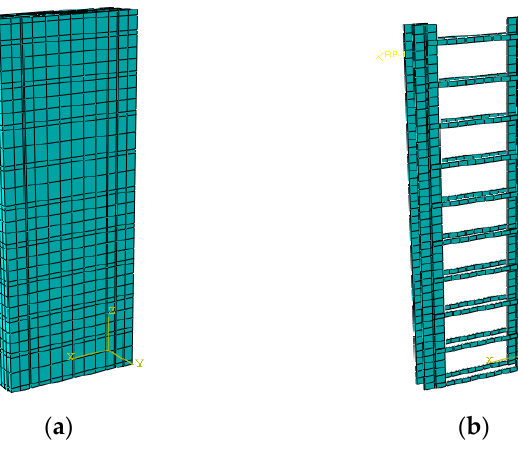
Figure 13. The Meshing of the Finite Element Model. ( a ) Concrete. ( b ) H-shape Steel. ( c ) Reinforce- ment Skeleton.